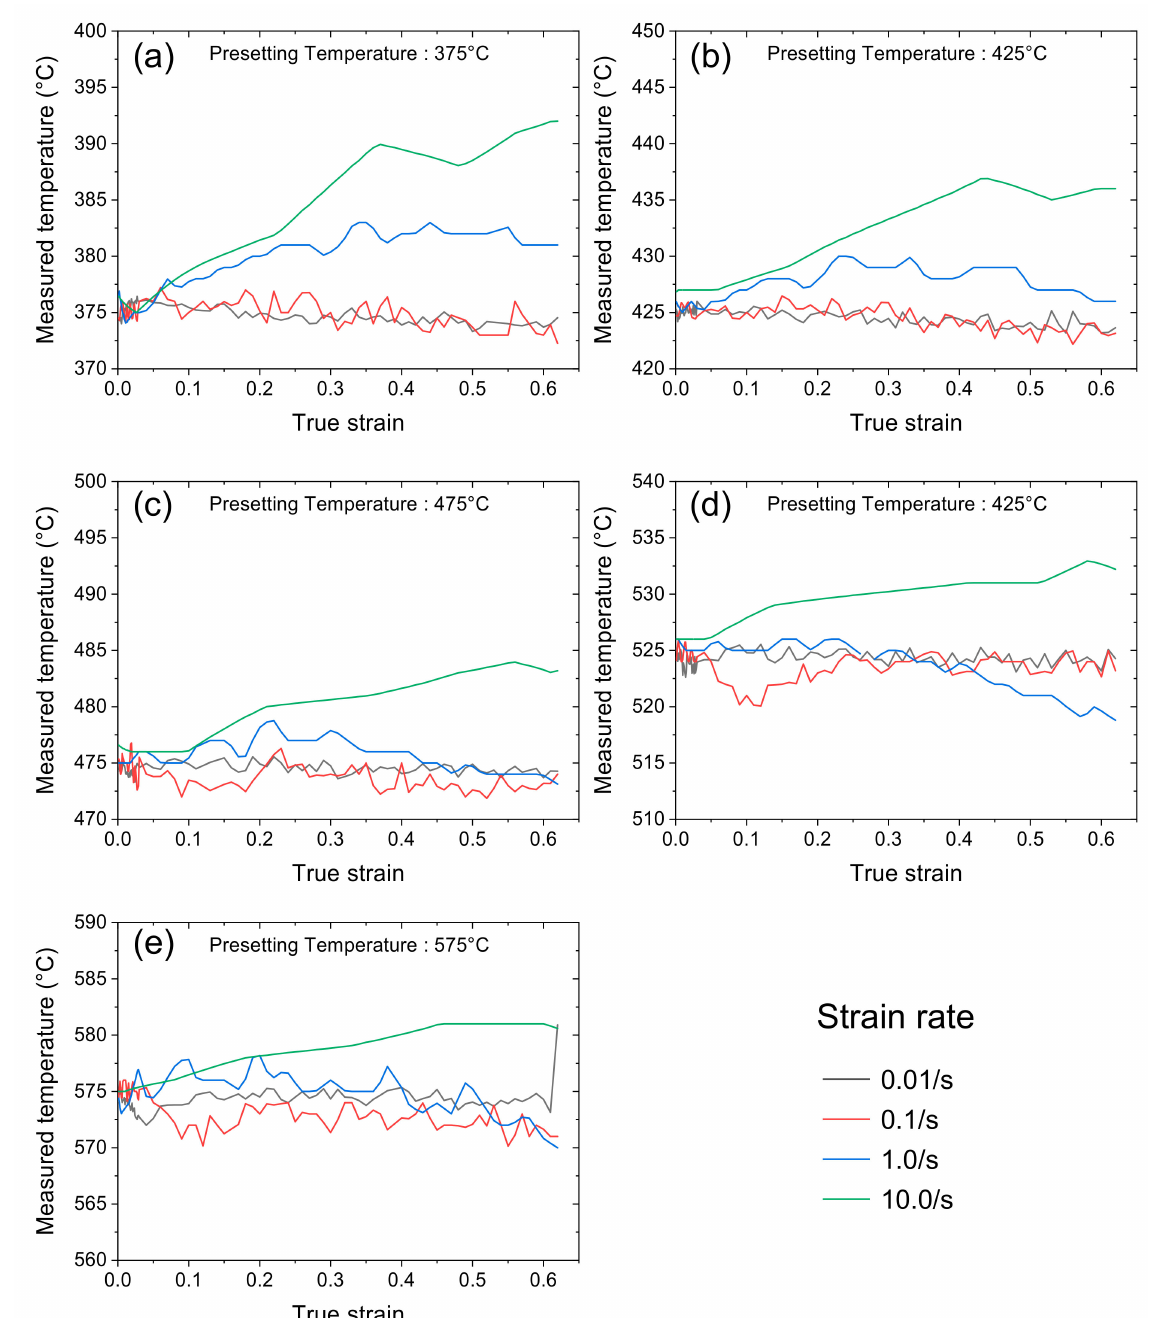
Figure 6. Measured temperature–strain curves during hot compression tests of AA6061 aluminum. The experiment data at different deformation conditions are grouped by the presetting temperature ( a ) 375 ◦ C, ( b ) 425 ◦ C, ( c ) 475 ◦ C, ( d ) 525 ◦ C and ( e ) 575 ◦